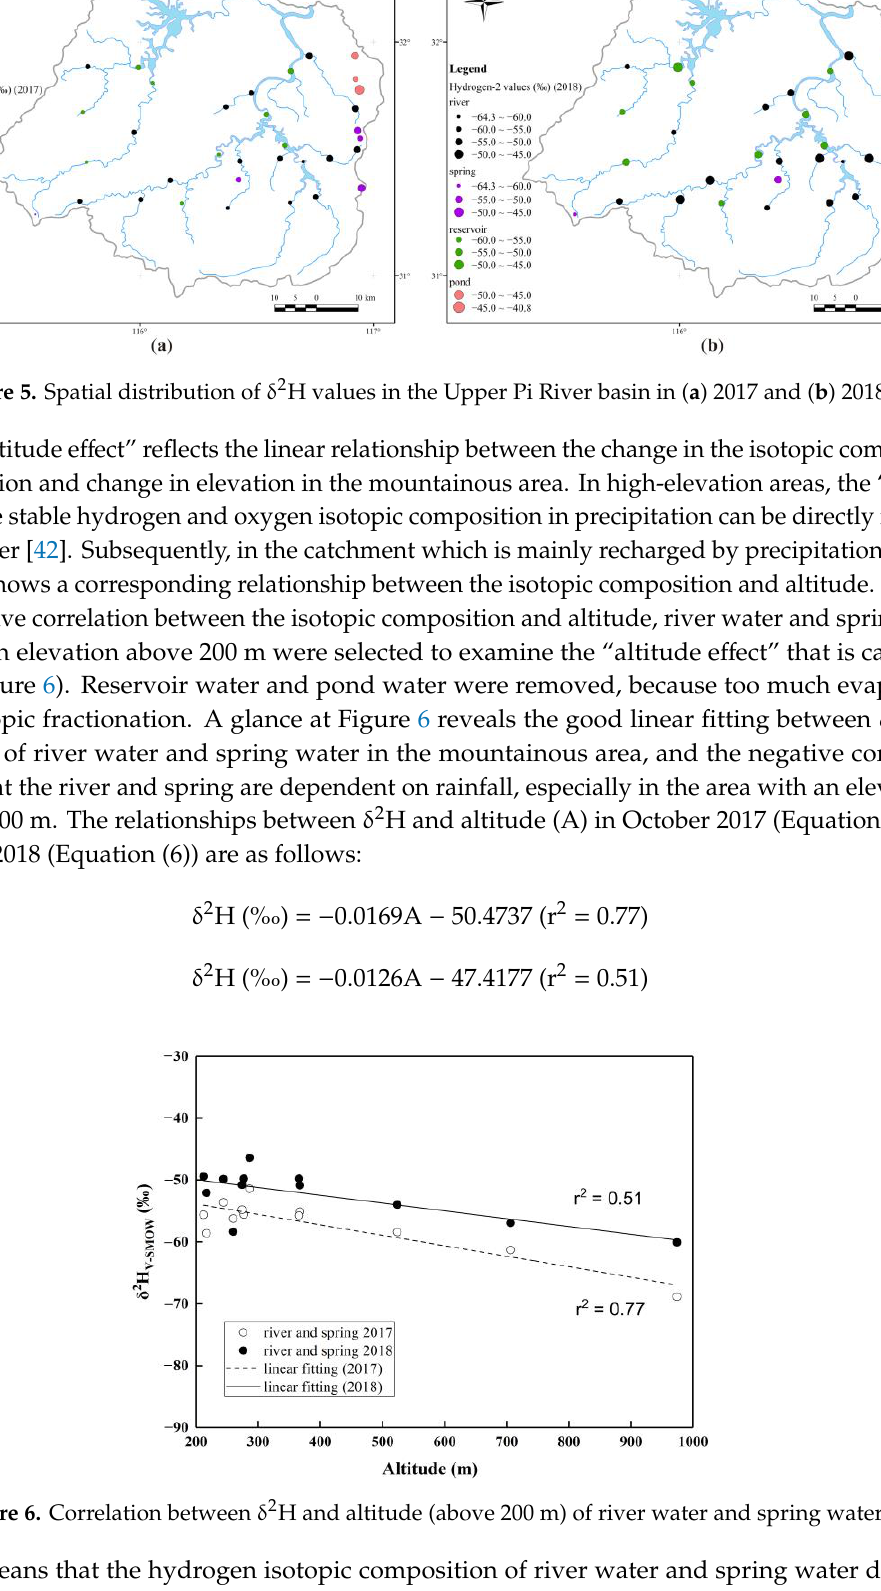
Figure 6. Correlation between δ 2 H and altitude (above 200 m) of river water and spring water.